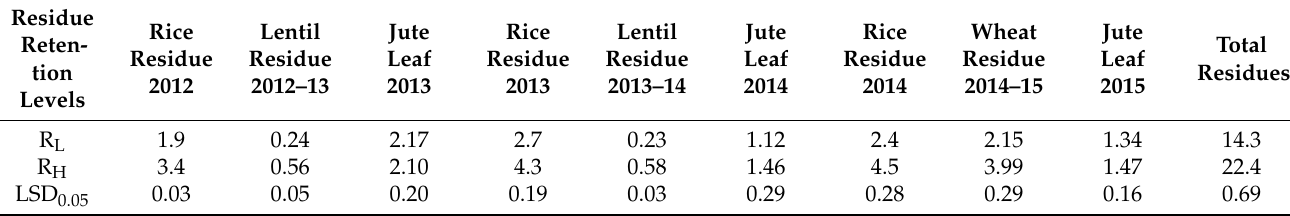
Table 1. Retention of residues by the component crops in the jute–lentil/wheat–rice cropping system over three years (t ha − 1 ). Values are the means of four